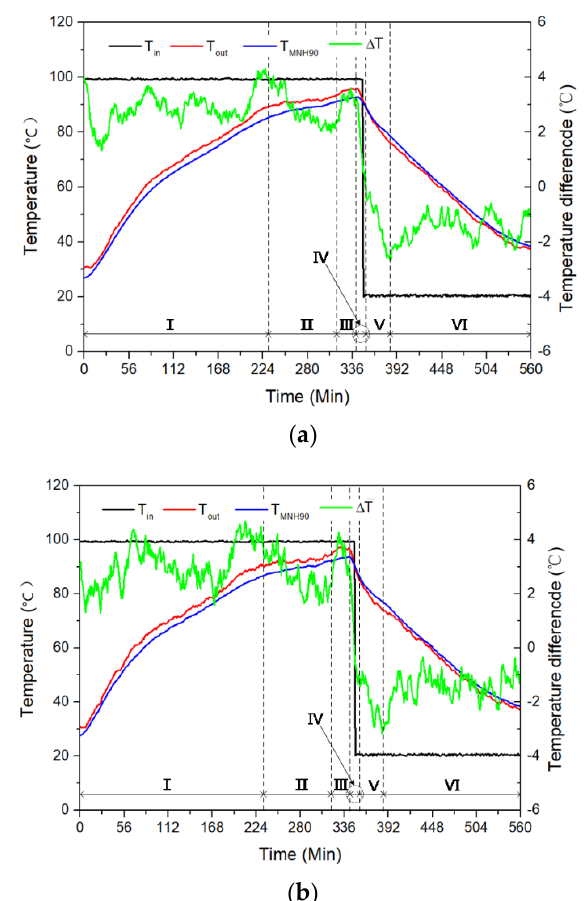
Figure 5. Temperature evolution of key measuring points of the phase change heat storage device ( a ) within the first typical charge–discharge operation ( b ) within the 800th typical charge–discharge operation.